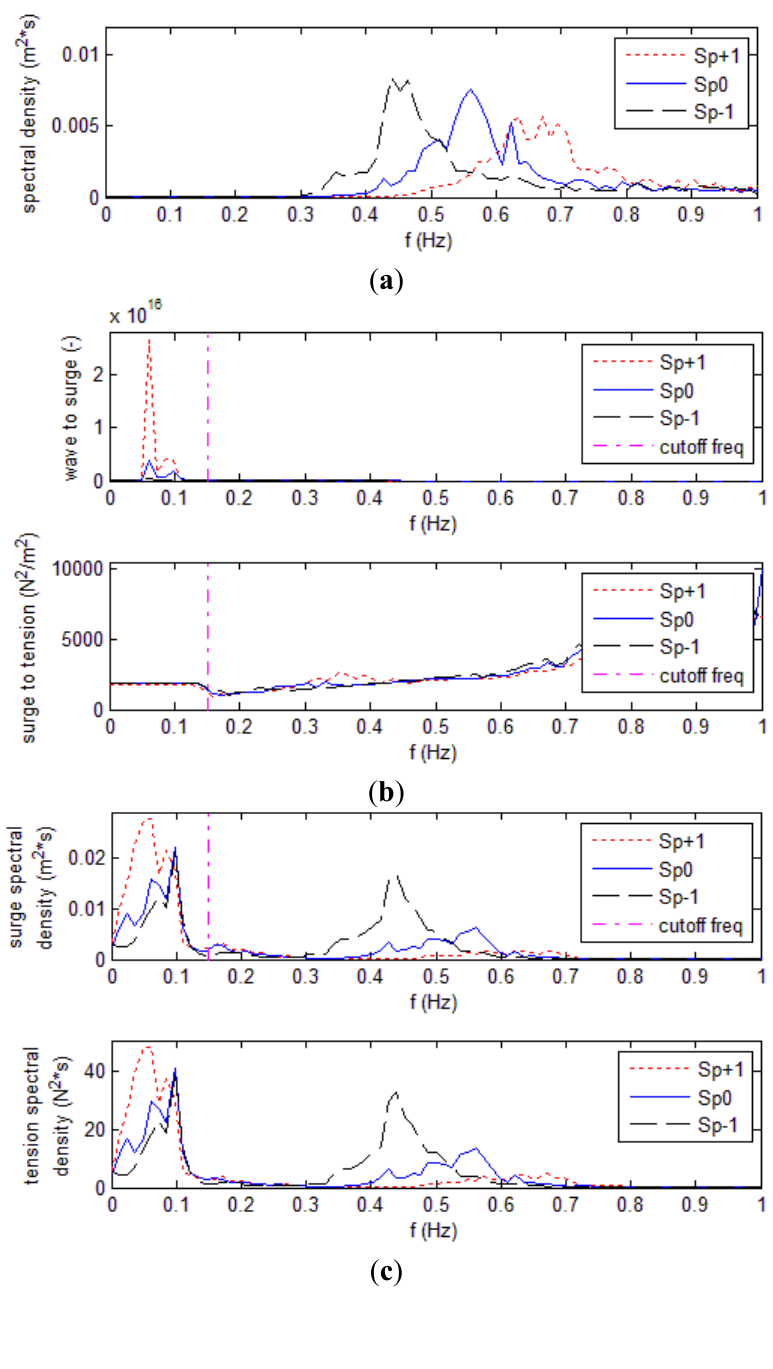
discussed. This results overall in a progressive shift of the spectral energy from high to low frequencies as the waves get steeper, both in the cases of surge and mooring tension. Figure 10. Frequency domain analysis of the system in design waves ( T and k mid. The cutoff frequency used in the surge signal reconstruction is shown by a vertical line at 0.15 Hz. ( a ) Incident wave spectra; ( b ) transfer functions from wave to surge and from surge to tension in the main mooring line; and ( c ) spectral response of the system in terms of surge and tension in the main mooring